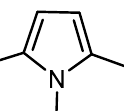
Figure 1. Structure formula of 1,2,5-trimethylpyrrole (TMP).